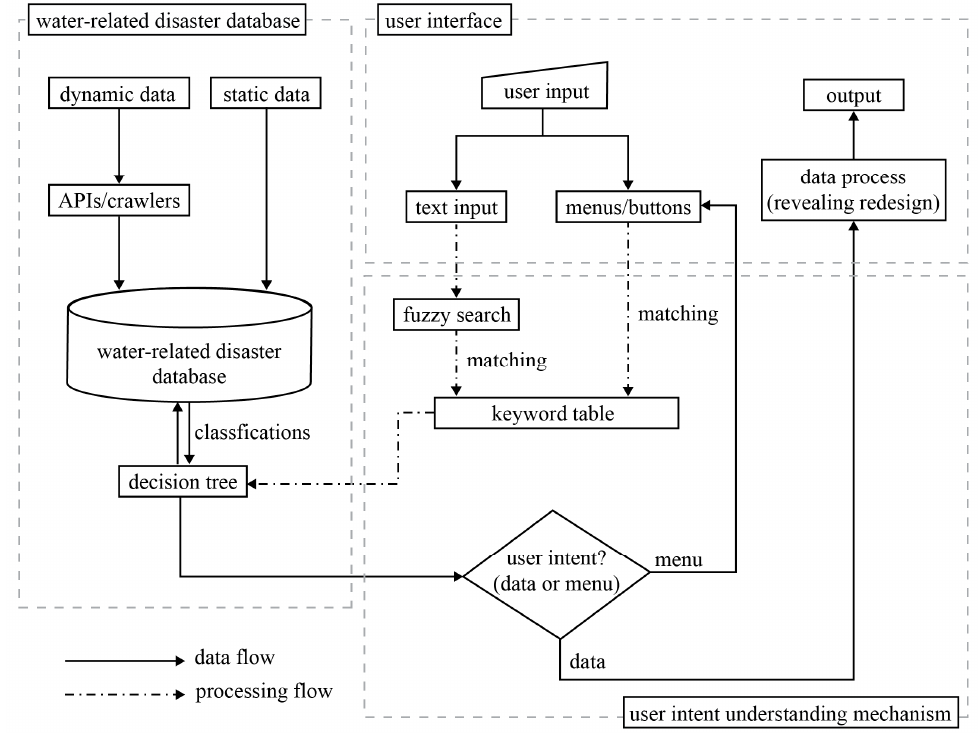
Figure 1. The system structure of Ask Diana.